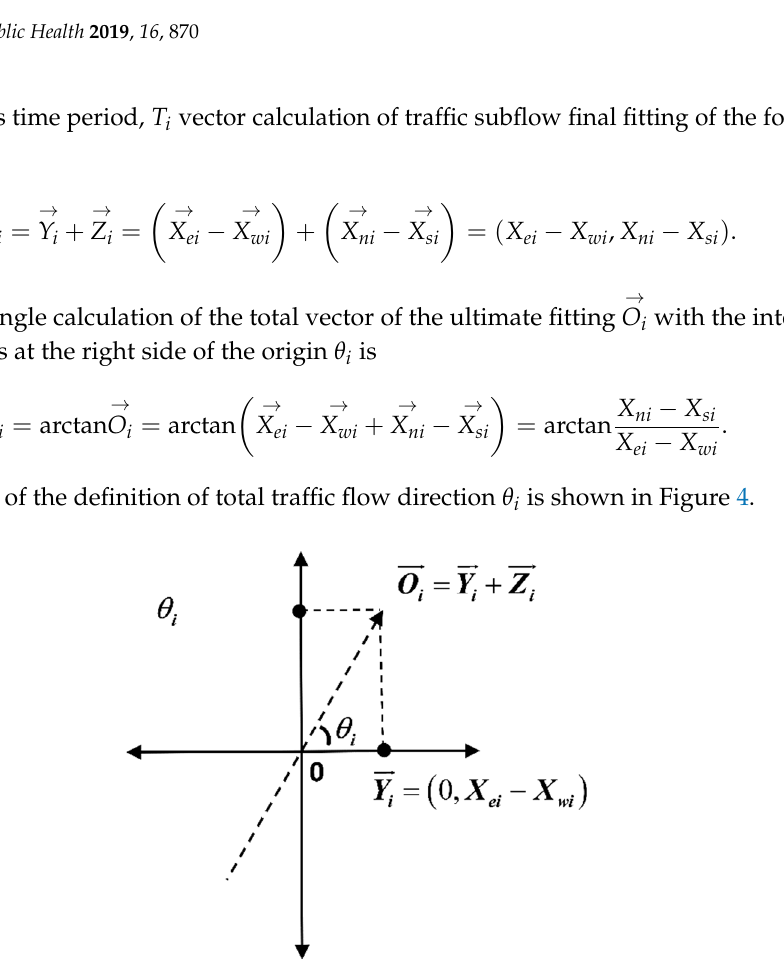
Figure 4. Diagram of the definition of total traffic flow direction θ i .